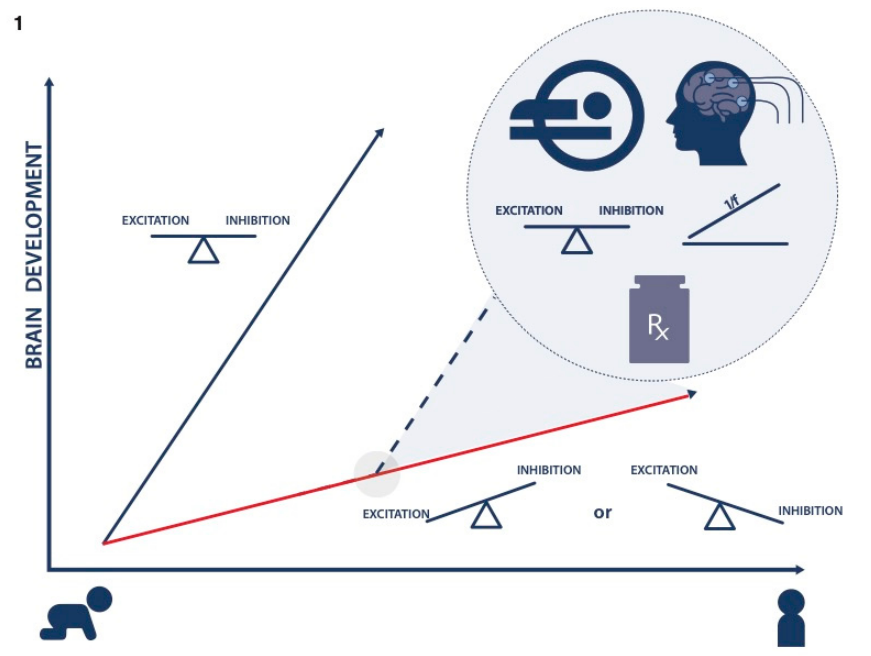
Figure 1. Precision medicine care for attention-deficit/hyperactivity disorder (ADHD). Red line represents atypical brain development and the blue line represents healthy brain growth. The dashed line represents projected healthy brain growth achieved by precision medicine care through early medical interventions guided by the measurements of excitation and inhibition (E/I) balance and 1/f ratio using MR spectroscopy (MRS) and electroencephalogram (EEG) methods.